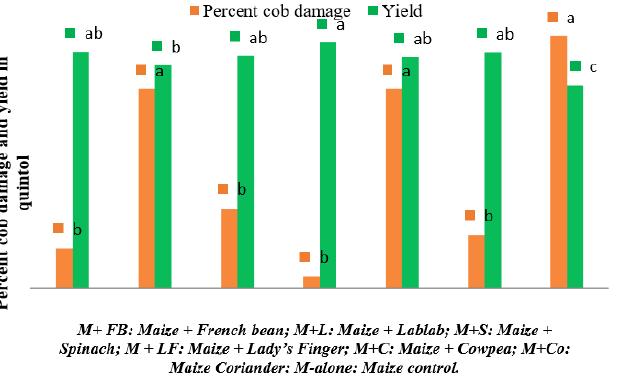
Figure 4. Percent cob damage by S. frugiperda and maize grain yield under different intercropping systems in New Delhi, India. [Bars of same colour marked with different letters differ significantly; p < 0.05, Duncan’s multiple range test].